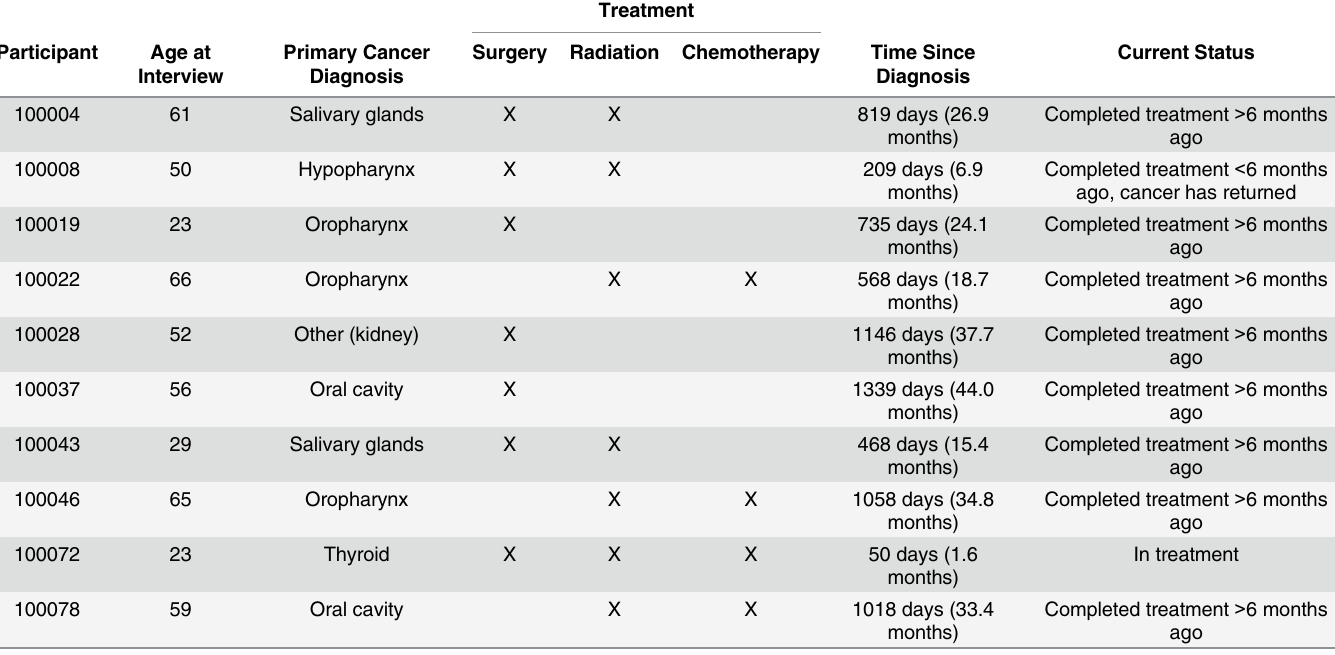
Table 1. Participants ’ Disease-related Characteristics.